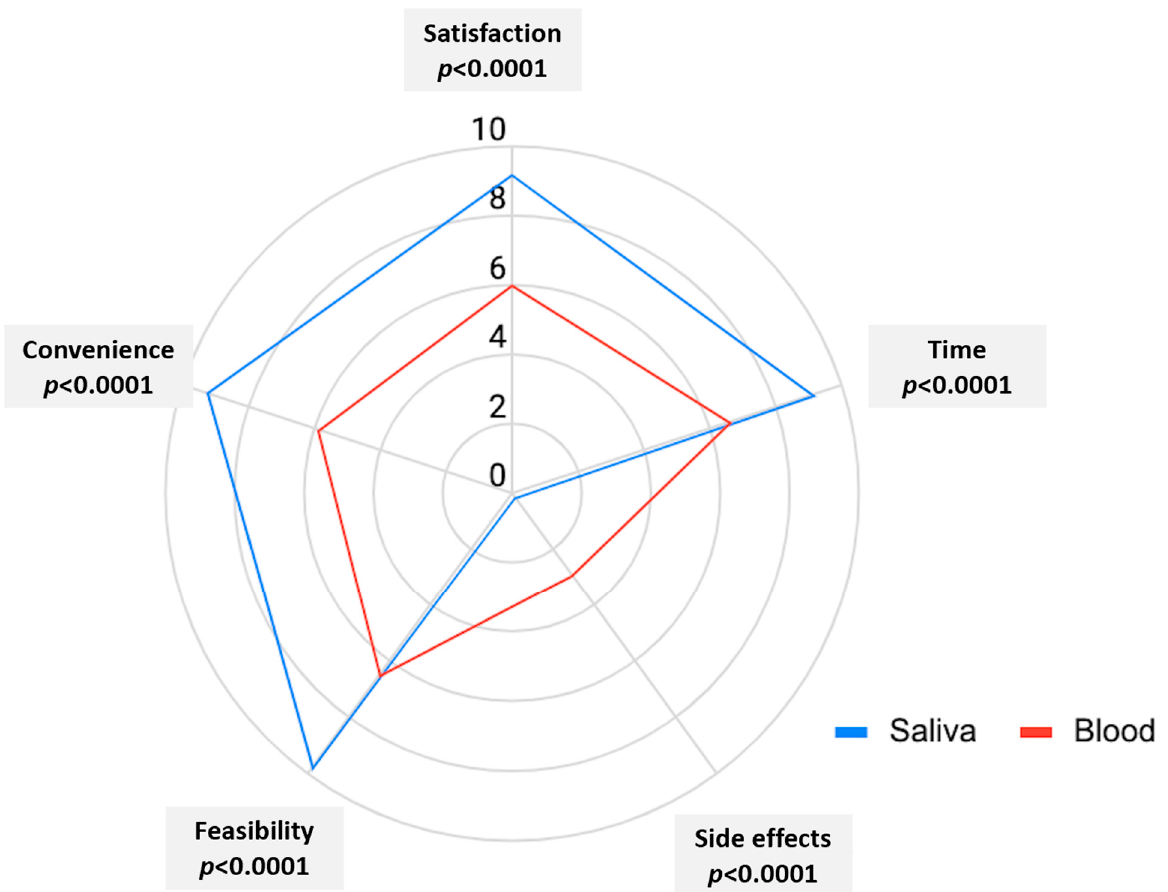
Figure 4. The radar chart showing the mean distributions of the scoring points for each item (satisfaction, time, feasibility, side effects, convenience). Results for all five parameters significantly favored saliva ( p < 0.0001 for all).